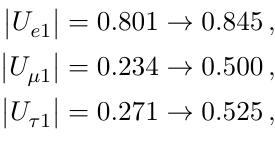
(cid:12) (cid:12) (cid:12) U αi (cid:12) (for α = e, µ, τ and i = 1 , 2 , 3 ) on the same